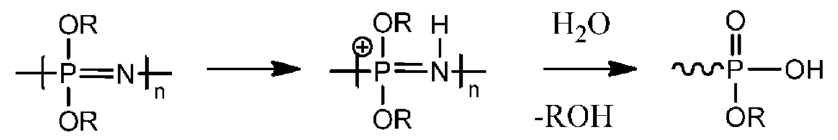
Figure 2. Acid catalyzed degradation mechanism. Figure 2 is adapted and reused from [24] with permission from MDPI, 2013, under Creative Commons Attribution license.